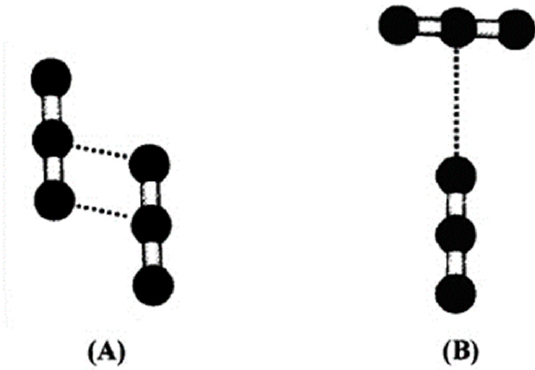
Figure 4. CO 2 dimers after [29]: ( A ) slipped-parallel and ( B ) T-Shaped.